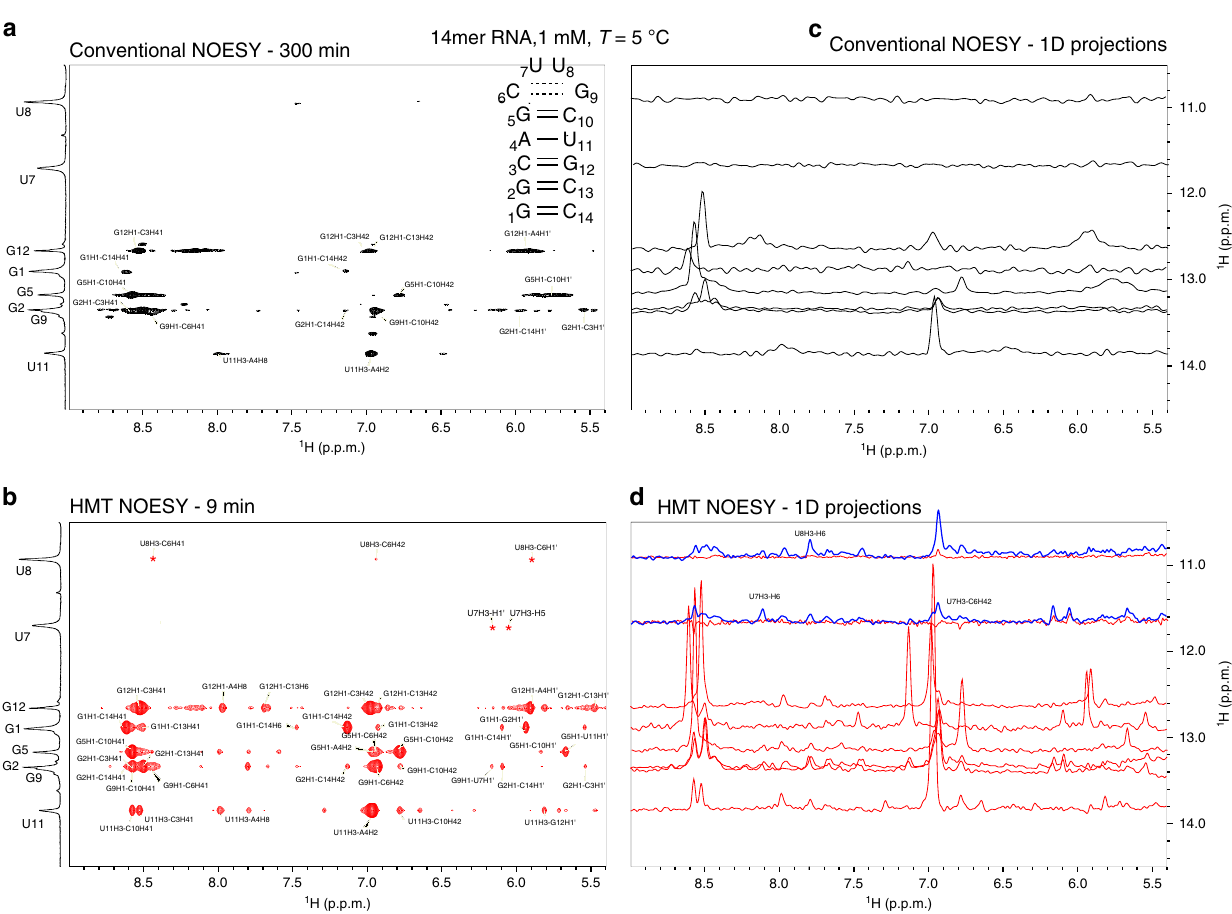
Fig. 3 HMT applied to enhance imino-derived correlations in RNAs. a Conventional (100 ms mixing) vs b HMT NOESY spectra (17 loops with a 20 Hz inversion pulse followed by 40 ms mixing each) recorded on the 14mer on top. Both 2D spectra show the imino resonances placed along the vertical direction; for maximizing its ef fi ciency, however, the conventional spectrum was acquired with the imino resonances along the direct domain, and was fl ipped in this graph to match the HMT data (otherwise, if encoding the iminos in t 1 , the conventional experiment showed no peaks altogether). As this was an 15 N-labeled sample, looped inversions/mixing periods were preferred over continuous saturations: this avoided a constant 15 N decoupling during the saturation period, which would have led to sample heating. Assignments are as labeled in the spectra; cross peaks labeled with asterisk are not visible at the given contour level. To better appreciate the enhancements, c and d show various 1D slices extracted from a and b , respectively. Shown in blue for the HMT NOESY are traces addressing U7 and U8 with a stronger (40 Hz continuous) saturation HMT scheme, revealing new correlations despite these sites ’ >30 s − 1 solvent exchange rates. All spectra were acquired at 1 GHz using a Bruker Avance Neo spectrometer equipped with a TCI